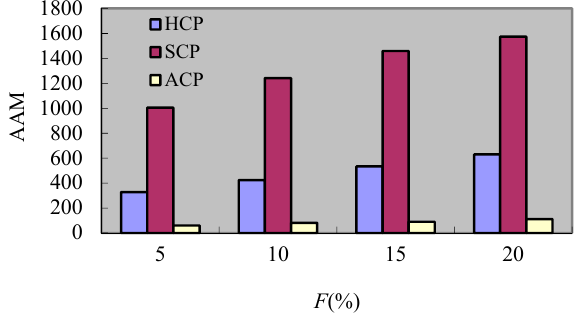
Figure 14. Impact of F on AAM.